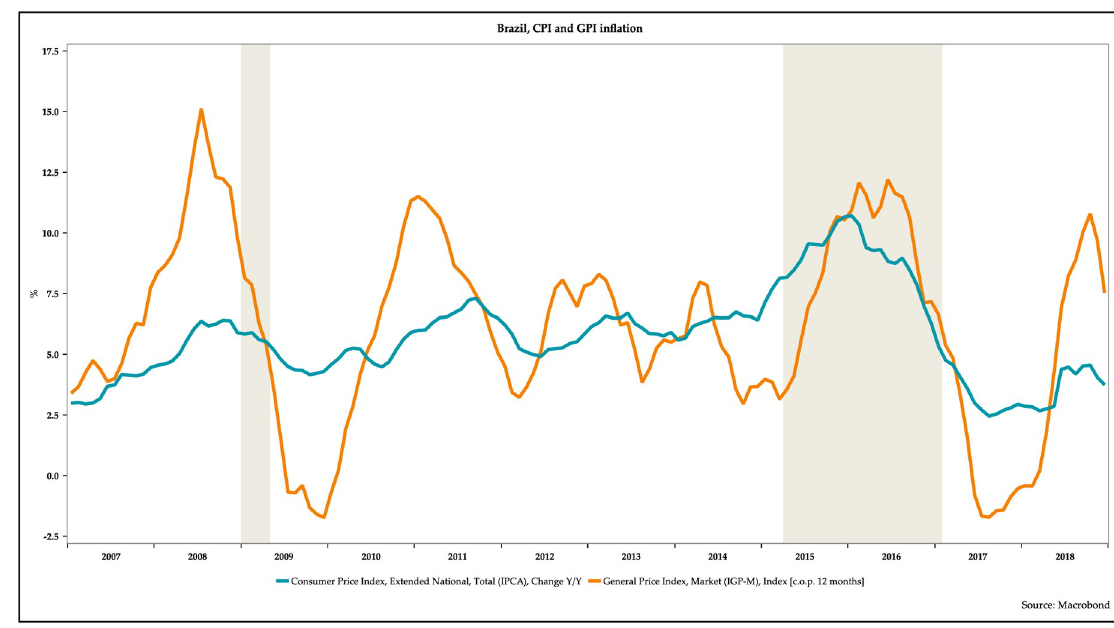
Fig 5. The evolution of inflation in Brazil, 2007–2018. https://doi.org/10.1371/journal.pone.0257313.g005 Fig 7 is a scatterplot of the yields of 10-year BGB and 30-day swap. Fig 8 is a scatterplot of the year-over-year percentage point changes in yields of 10-year BGB and 30-day swap. Addi- tional scatterplots are available in the working paper. These scatterplots demonstrate some fascinating patterns. First, the yields of long-term BGBs and short-term securities, as measured by swap rates, are positively and tightly corre- lated. Second, the changes of the yields of long-term BGBs and short-term interest rates, as measured by swap rates, are also positively correlated, though less so than in the levels of the yields. Third, these correlations weaken somewhat as the maturity tenor of the long-term BGBs rise.